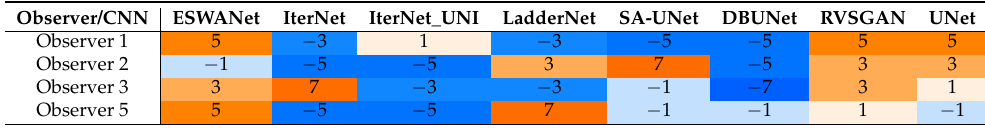
Table 7. CNN model ranking based on the Copeland score for each of the observers. The larger the value is, the more significant the model is clinically. Absolute values of the Copeland score are in the [ − 8, 8] range.